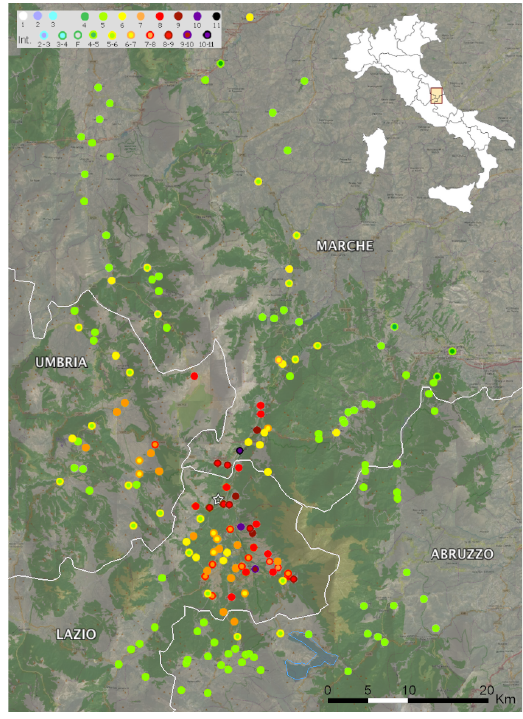
Figure 1: I intensities observed after the August EMS 24, 2016 event (damage up to September 6, 2016).